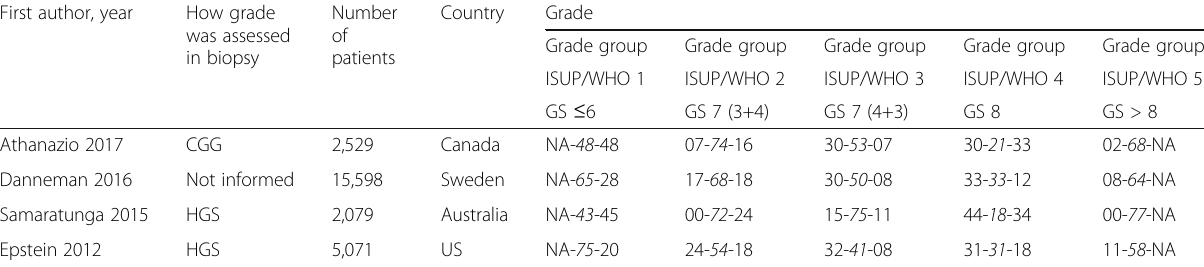
Table 2 One-level downgrade, concordance, and one-level upgrade when compared with biopsy Grade Group and radical prostatectomy Grade Group in large series post-2005 ISUP consensus. One-level downgrade rate is shown at the right, concordance rate is centered and italicized, and one-level upgrade is shown at the left. Rates are expressed as